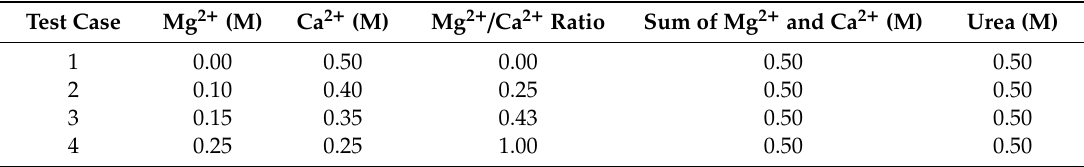
Table 2. Microbial induced carbonate precipitation and sand solidification test conditions with magnesium